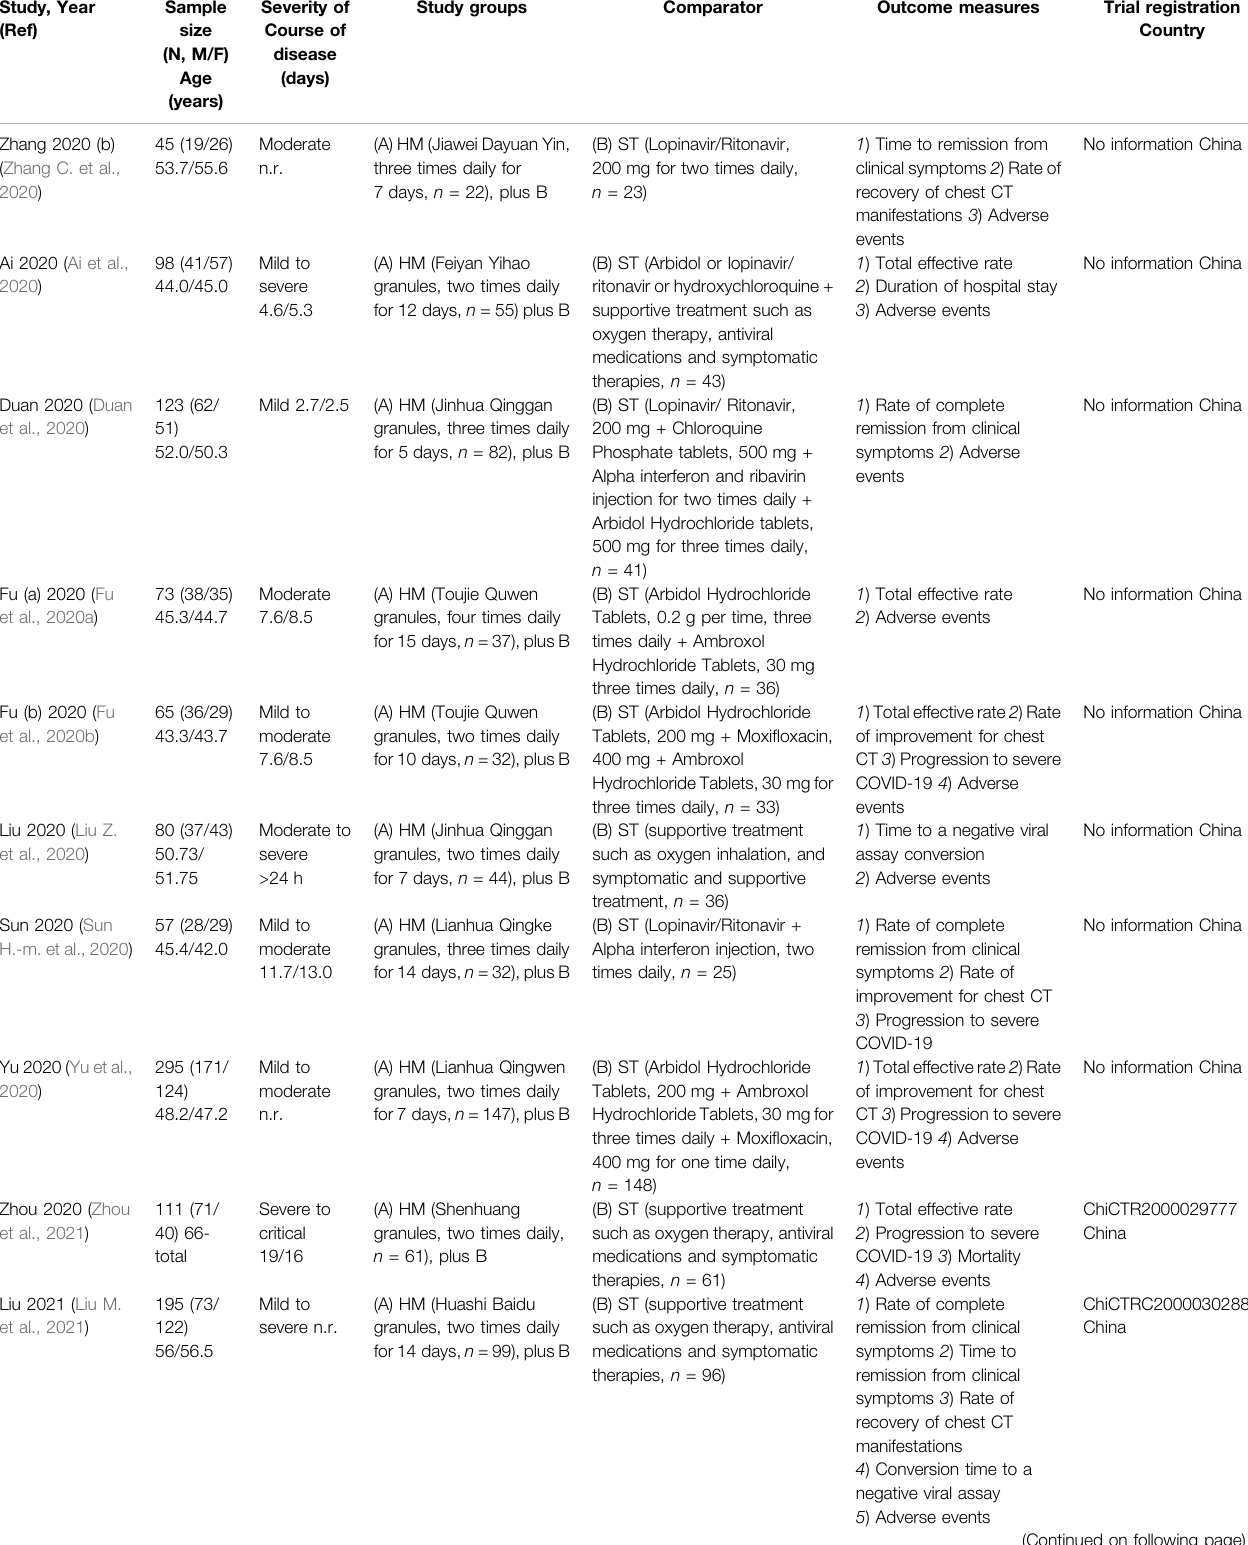
TABLE 1 | ( Continued ) Study characteristics of trials conducted with herbal medicine for the treatment of